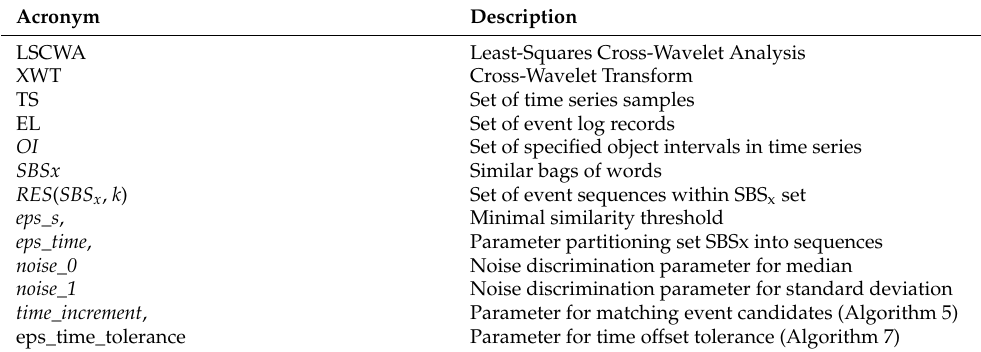
Table A1. Basic acronyms used in the